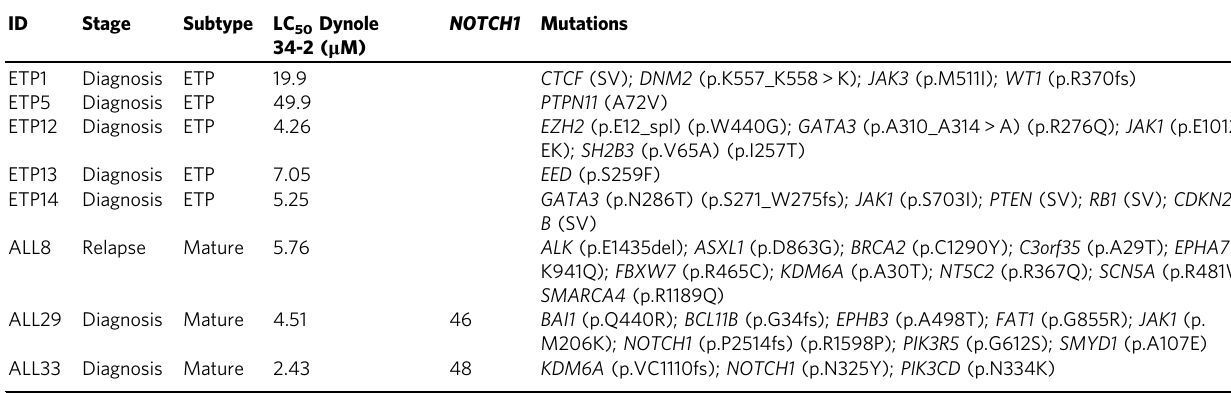
Table 1 Sensitivity of primary T-ALL xenograft to Dynole